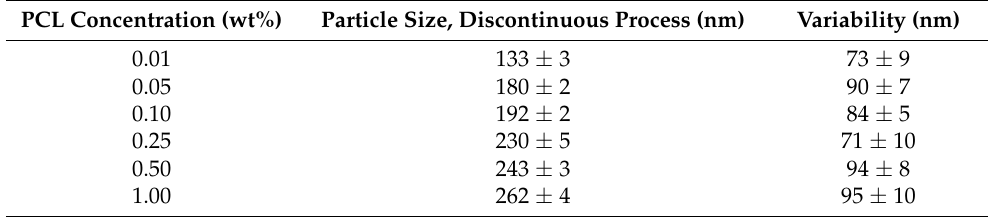
Table 1. Particle sizes achieved by a discontinuous process using different concentrations of PCL. PCL Concentration